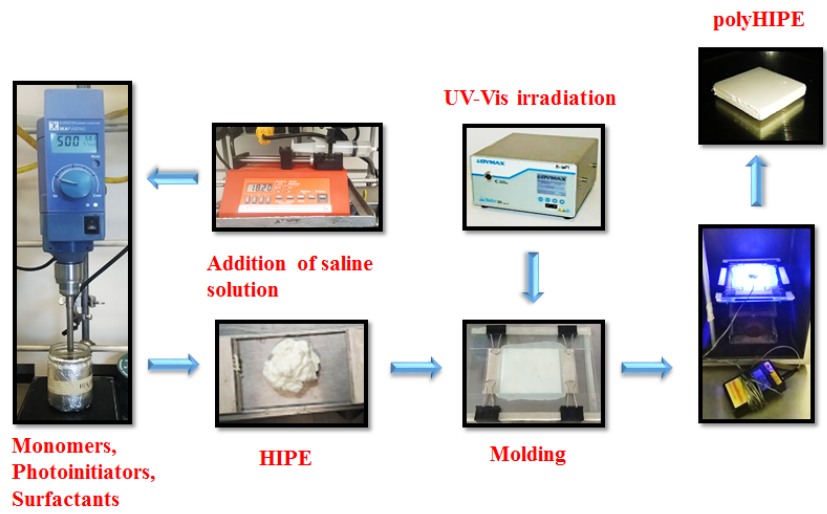
Figure 3. Methodology to obtain the photocurable polyHIPEs.